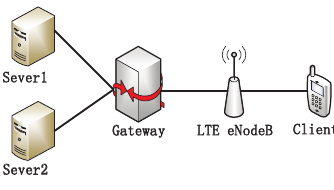
Figure 1. Simulation topology.